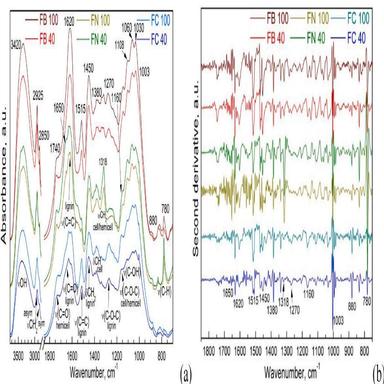
FT-IR spectra of bark, cones and needles of fir biomass (a) and the second derivative of the IR spectra in the 1800-800 cm− 1 fingerprint region (b).